Question: Summarize what this figure shows in one sentence.
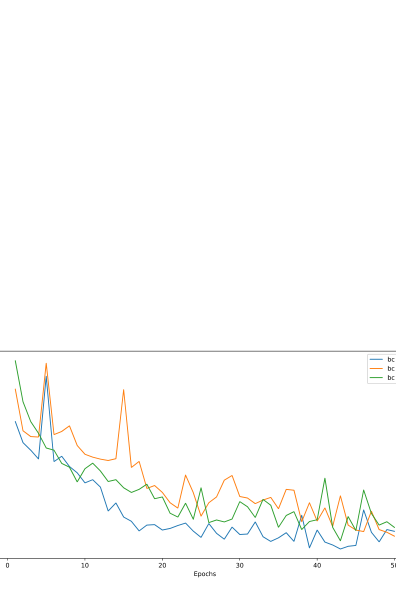
Answer: Loss at different batch sizes.